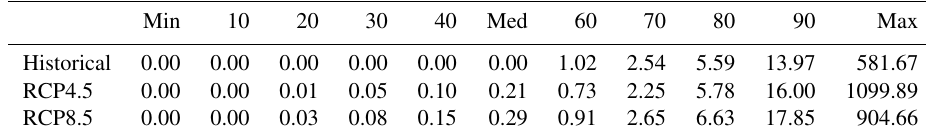
Table 4. CanESM2 daily total precipitation (mm) quantiles for the observed historical (GHCN) climate (1980–2005), the downscaled RCP4.5 climate (2006–2100), and the downscaled RCP8.5 climate (2006–2100) across all 23 locations.